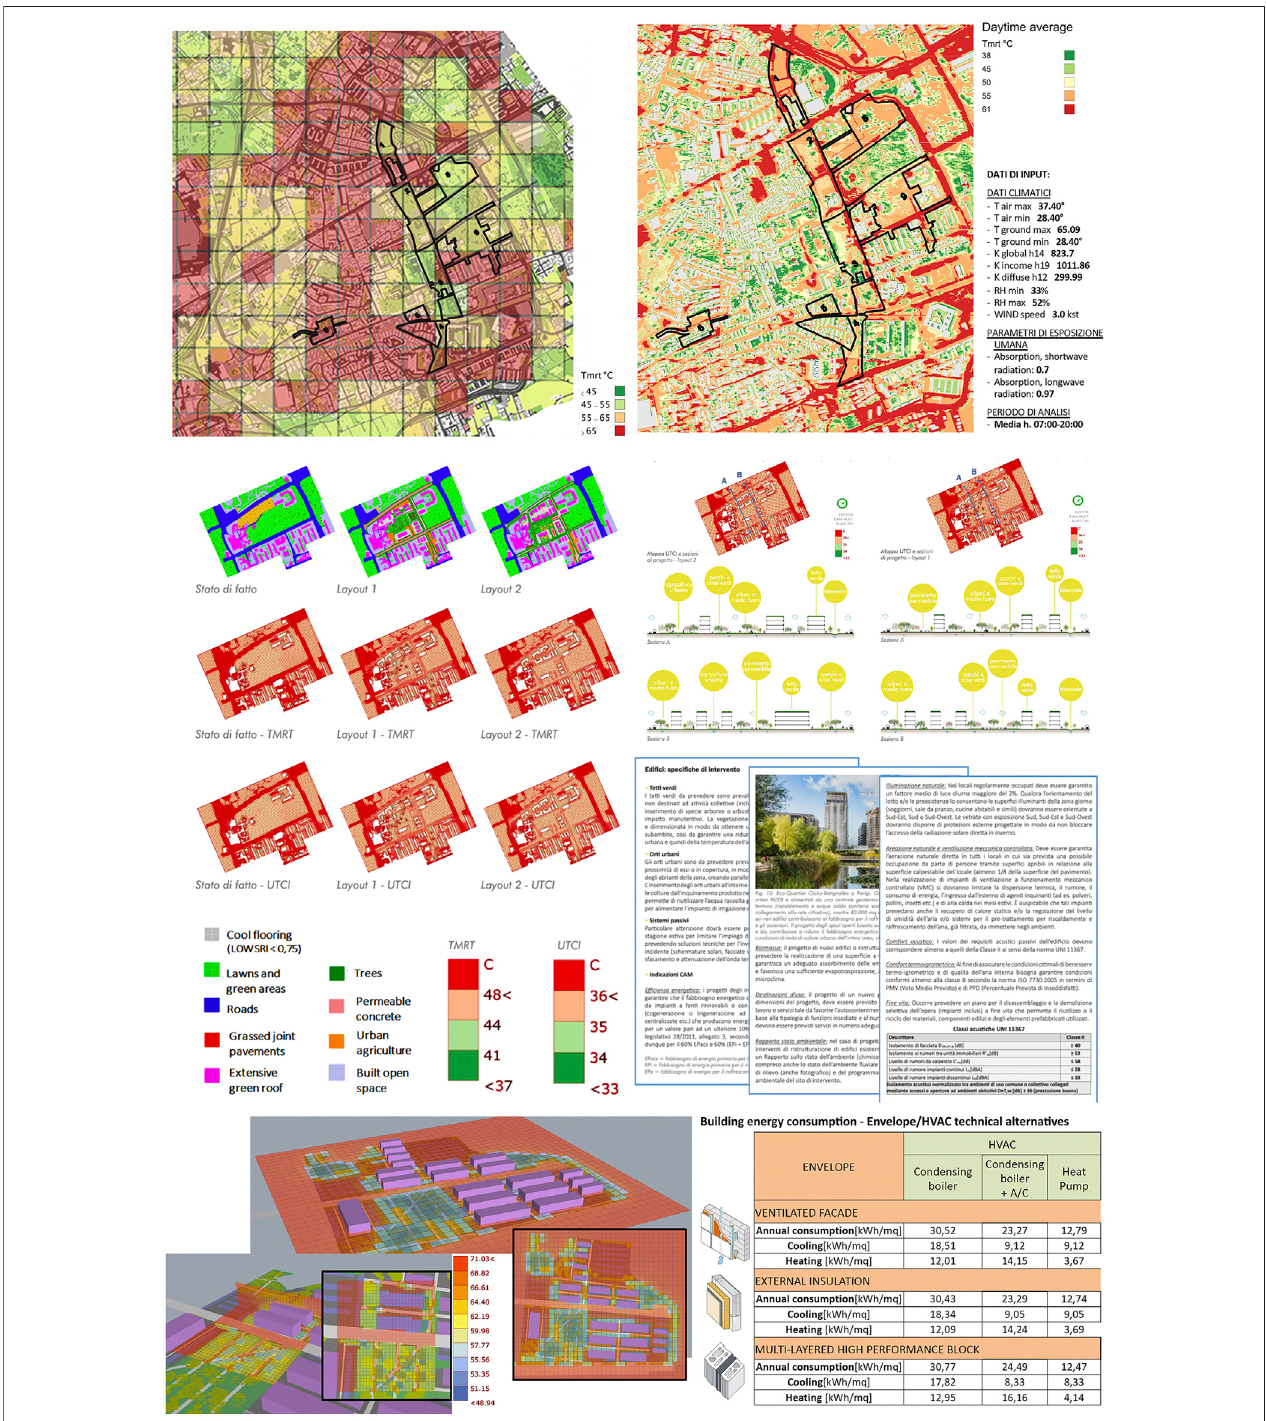
FIGURE 14 | Example of outputs from the expert level study carried out for the PRU in Ponticelli.